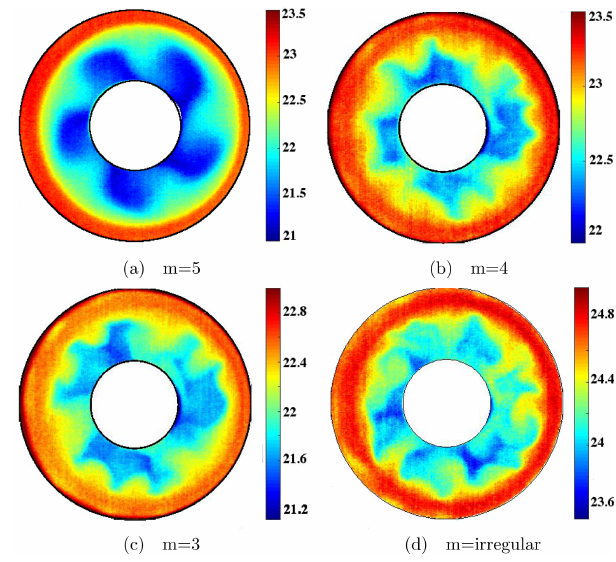
Figure 3. Flow regimes at (cid:49)T = 7 . 1K (a) , (cid:49)T = 5 . 2K (b, c) , and (cid:49)T = 3K (d) . The flow becomes more irregular for decreasing (cid:49)T